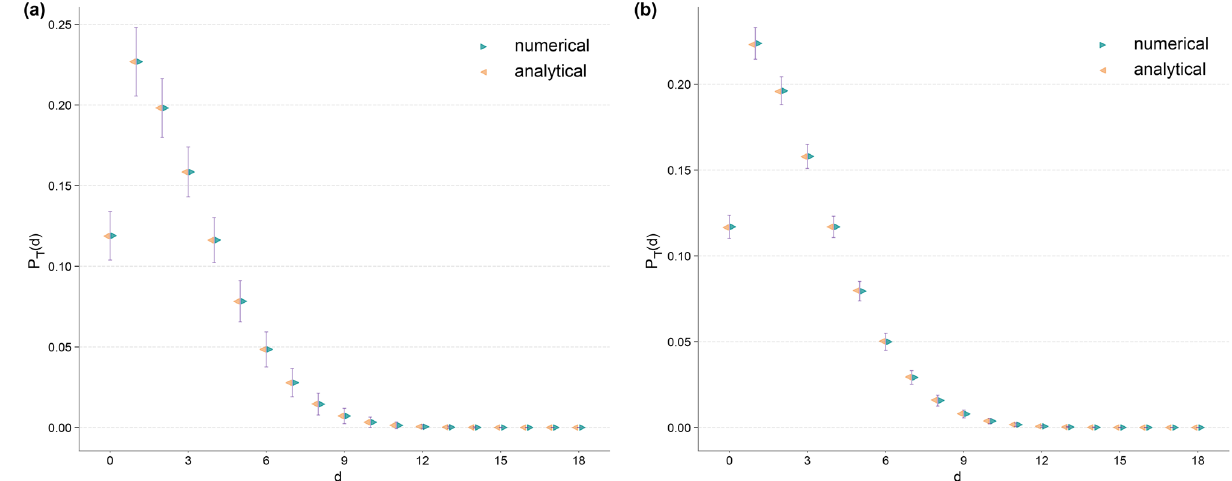
Figure 3. Concordance between analytical formula for DD distribution and numerical computations in Erdős– Rényi (ER) model. ( a ) Computations for ER graph with 200 vertices and average degree ∼ 6 . In this case, Eq. (9) is used to obtain the analytical result. ( b ) Computations for ER graph with 1000 vertices and average degree ∼ 6 . In this case, Eq. (12) is used to obtain the analytical result. In both cases, the numerical result is obtained via averaging the computed P (cid:31) over an ensemble of 10,000 ER networks with same size and average degree. Note 6 that P (cid:31) ( d ) is of the order of 10 − or smaller for d > 18 , thus given our ensemble size, the comparison between the numerical and analytical computations is not valid, and thus not shown, for d > 18